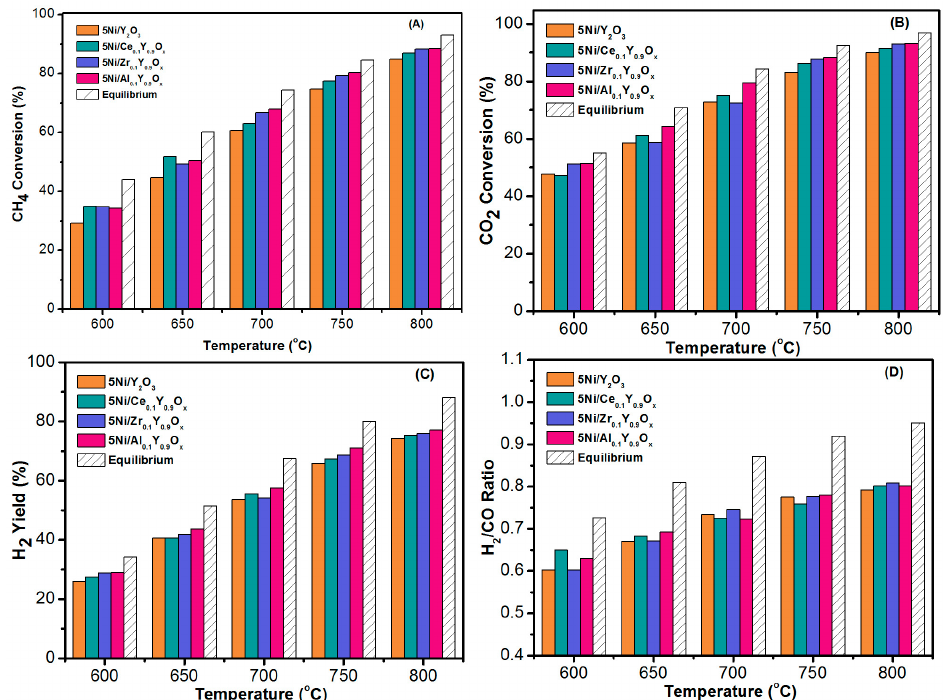
Figure 2. DRM reaction performance of the catalysts: ( A ) CH 4 conversion, ( B ) CO 2 conversion, ( C ) H 2 yield, and ( D ) H 2 /CO Ratio.